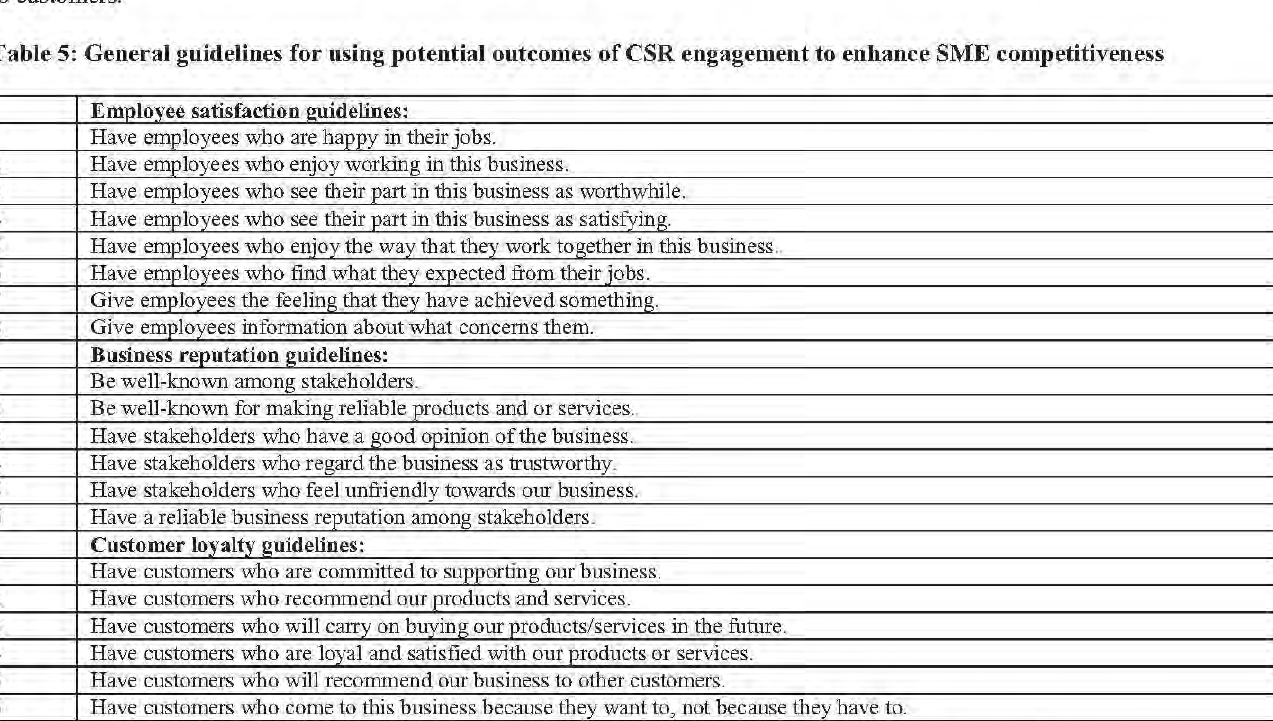
Table 5: General guidelines for using potential outcomes of CSR engagement to enhance SME competitiveness Employee satisfaction